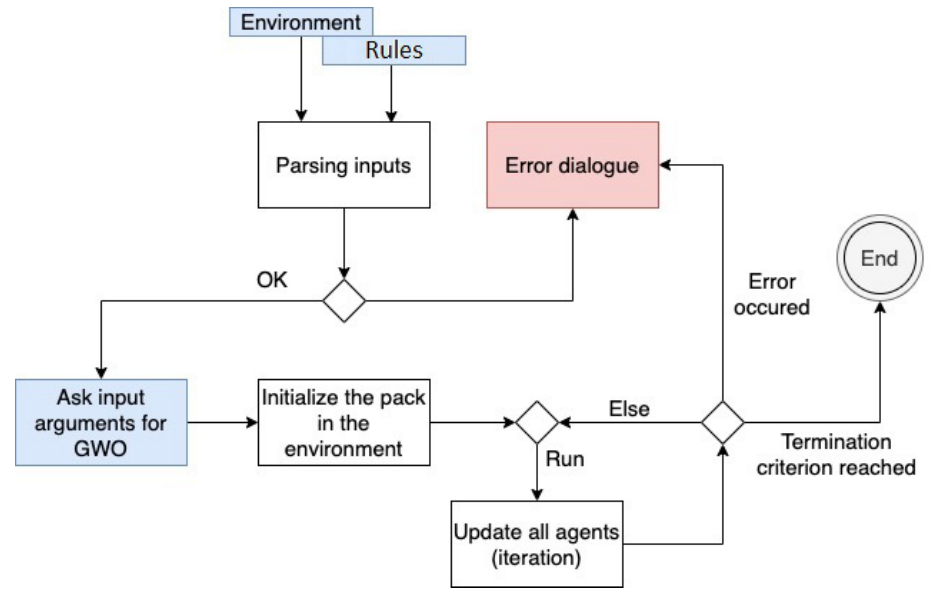
Figure 7. Flowchart diagram of the algorithm.